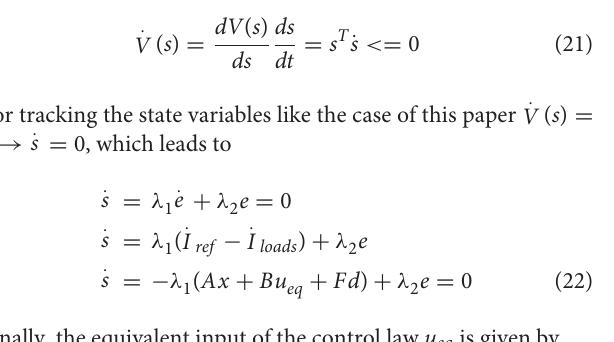
Frontiers in Energy Research |